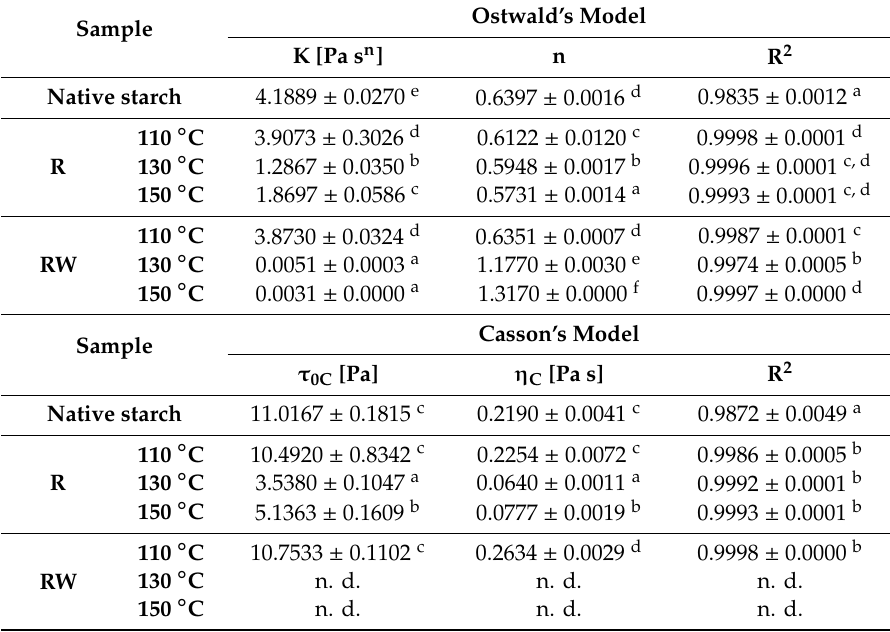
Table 2. Parameters of Ostwald’s and Casson’s model describing the flow curves of the native and modified starch